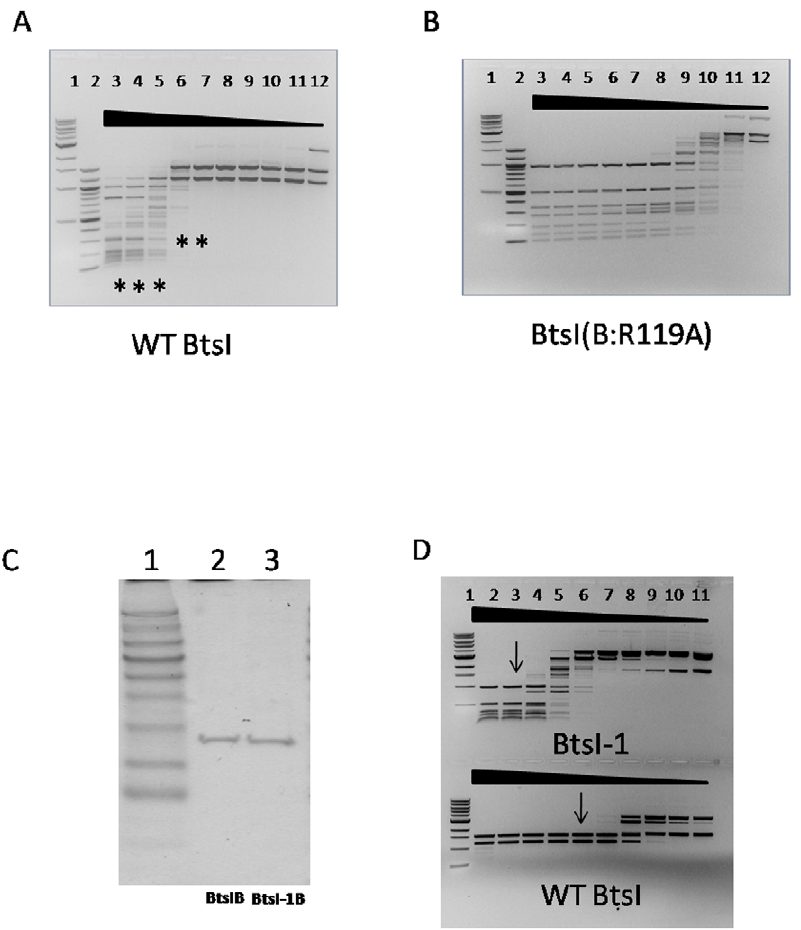
Figure 2. BtsIB(R119A) has different cutting patterns and less specific activity compared with wild type BtsIB. A: A 2-fold serial dilution of wild type BtsIB ( , 28 pmol) was mixed with a constant concentration of excess BtsIA ( , 43 pmol) and used to digest pUC19 (0.6 m g) in NEB4 at 55 u C for 1 hour (lane 3–12). Symbol stars (*) from lanes 3–7 indicate that star activities appear under these BtsI concentrations. Lanes 8–10 show complete digestion patterns. Lanes 11–12 show incomplete digestion pattern. B: A 2-fold serial dilution of BtsIB(R119A) ( , 20 pmol) was mixed with a constant concentration of excess BtsIA ( , 43 pmol) and used to digest pUC19 (0.6 m g) in NEB4 at 55 u C for 1 hour (lanes 3–12). Lanes 3–7 show complete digestion patterns, whereas lanes 8–12 show incomplete digestion patterns. Lane 1: 1 kb DNA Ladder (NEB # N3232); Lane 2: 100 bp DNA Ladder (NEB N3231). C: The same concentration of BtsIB and BtsI-1B ( , 1.8 m M) were resolved by SDS-PAGE and stained with Coomassie Blue. D: The same amount of BtsIB and BtsI-1B ( , 3.6 pmol) were mixed with BtsIA ( , 3.6 pmol) at the molar ratio of 1:1 and then were serially diluted by 2-fold to digest pUC19 (0.6 m g) in NEB4 at 55 u C for 1 hour. Arrows indicates the lane with minimal amount of protein for complete digestion.